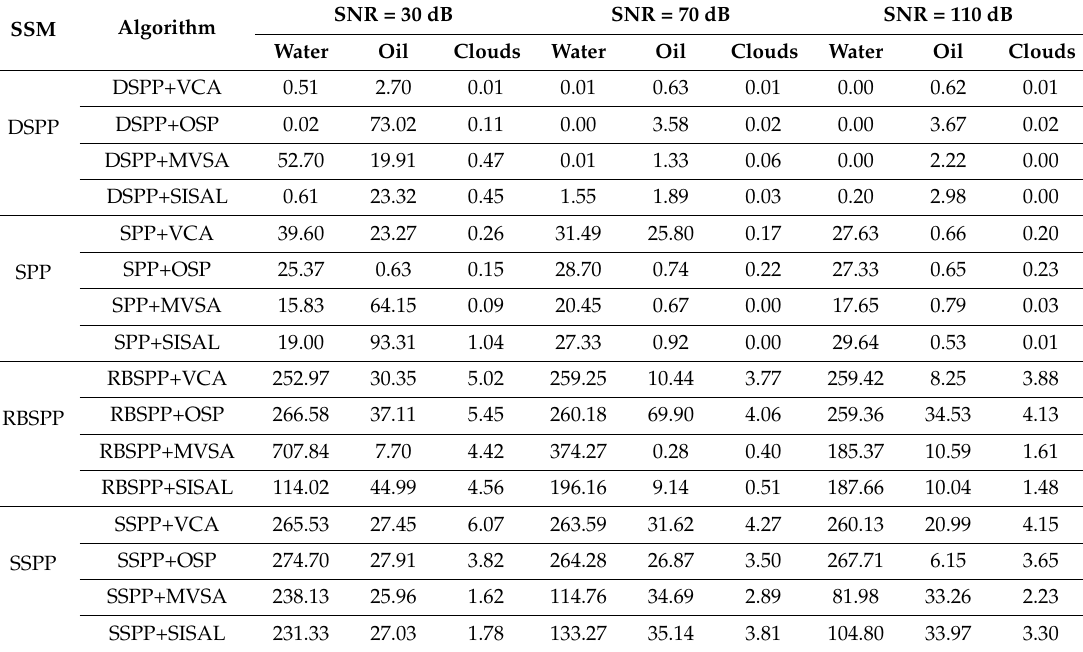
Table 1. SSM values of endmembers obtained using different SNRs and several different algorithms.